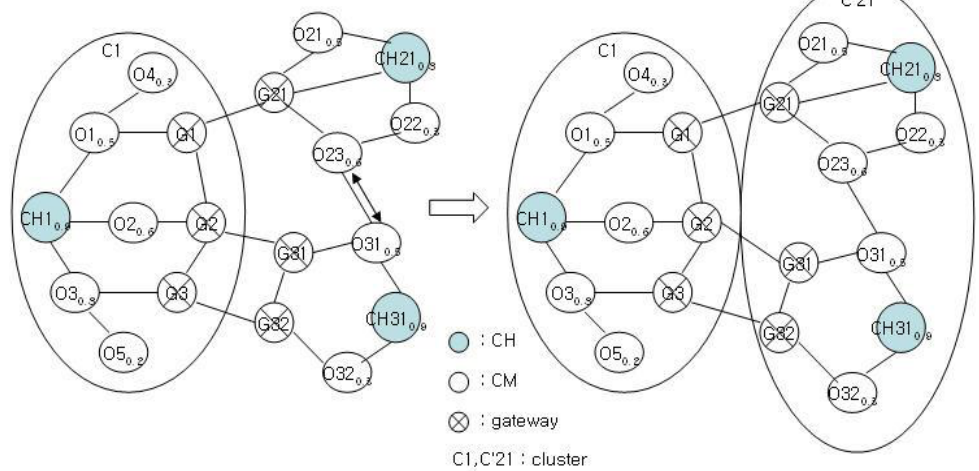
Figure 5. Modified Cluster